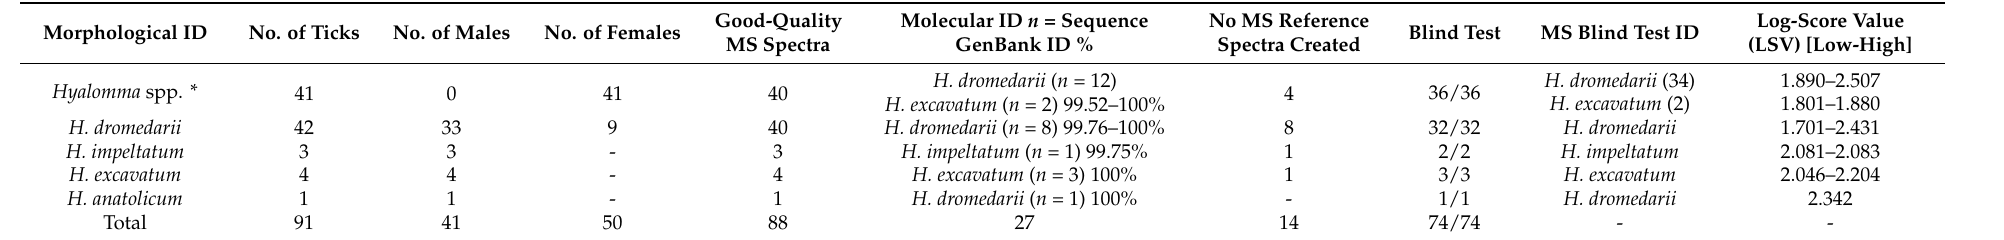
Table 1. Ticks used for the creation of MALDI-TOF MS reference database and blind